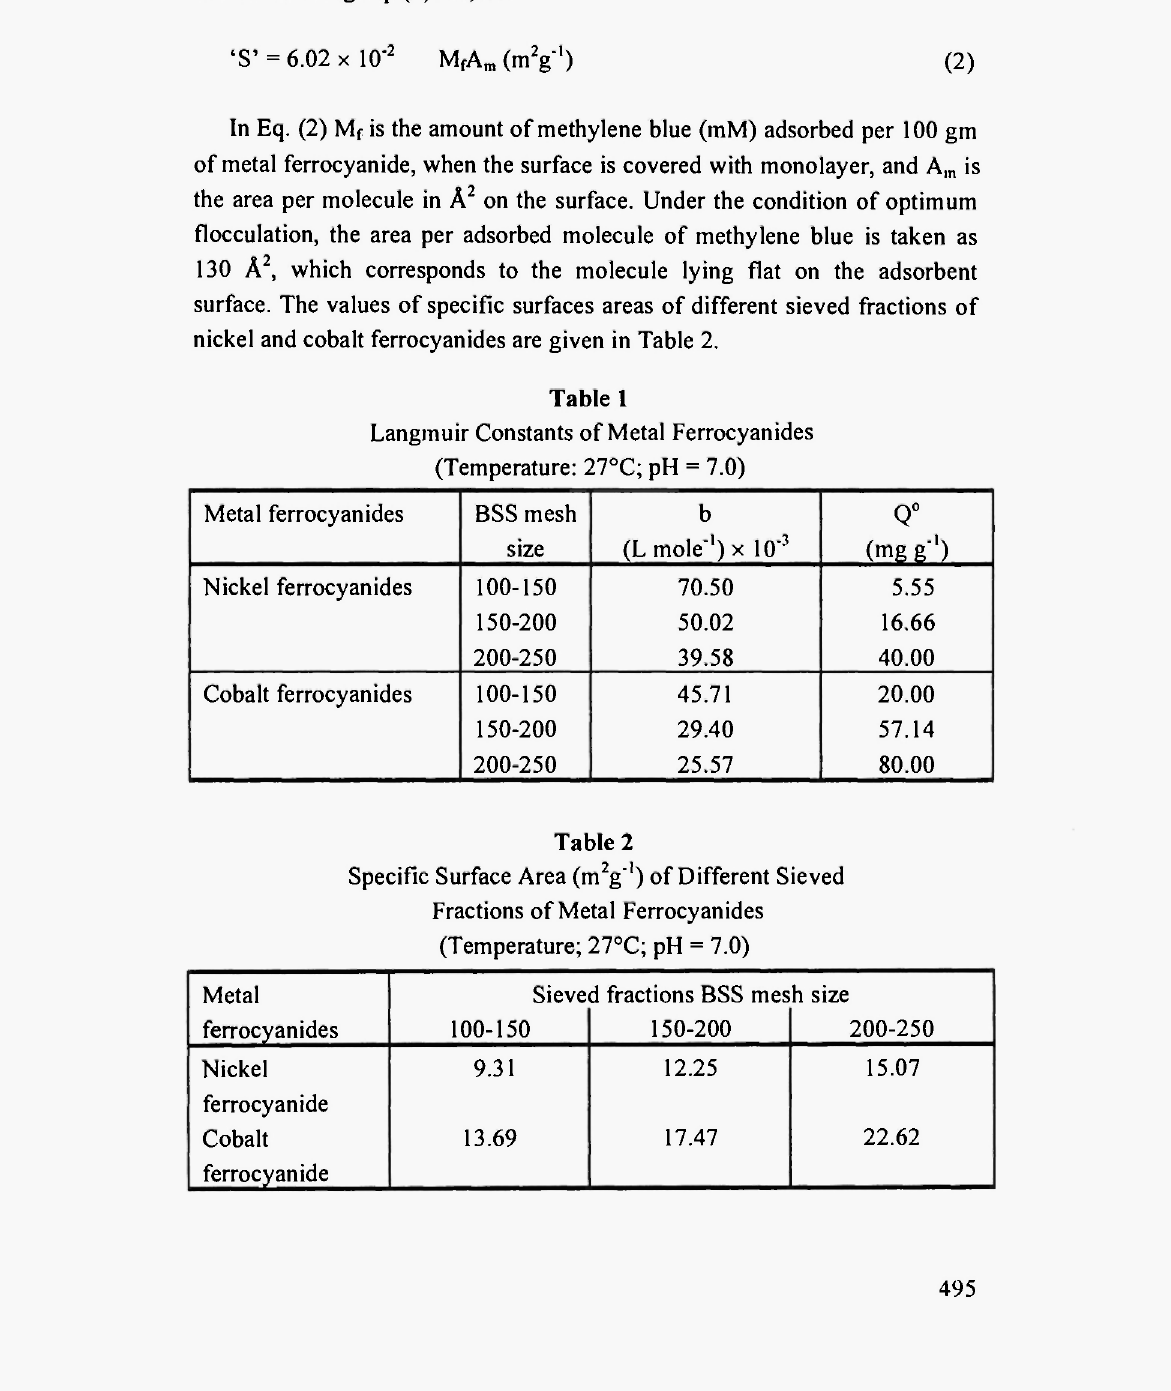
Langmuir Constants of Metal Ferrocyanides (Temperature: 27°C; pH = 7.0)